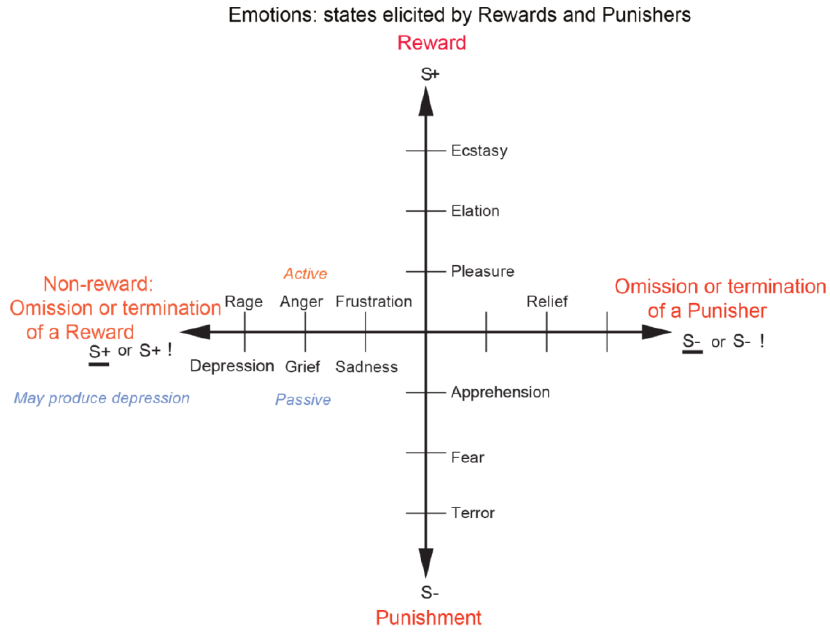
Figure 4 : Some of the emotional states associated with different reinforcement contingencies are indicated. Intensity increases away from the centre of the diagram, on a continuous scale. The classification scheme shows how different emotional states created by the different reinforcement contingencies consist of being in a state that leads to (1) performing an action to obtain a reward (S+), (2) performing an action to escape from or avoid a punisher (S-), (3) performing an action, or not, because of the omission of a reward (S+) (extinction) or the termination of a reward (S+!) (time out), and (4) performing an action, or not, because of the omission of a punisher (S-) (avoidance) or the termination of a punisher (S-!) (escape). Note that the vertical axis describes emotional states associated with the delivery of a reward (up) or punisher (down). The horizontal axis describes emotional states associated with the non- delivery of an expected reward (left) or the non-delivery of an expected punisher (right). For the contingency of non- reward (horizontal axis, left), different emotions can arise depending on whether an active action is possible to respond to the non-reward, or whether no action is possible, which is labelled as the passive condition. The diagram summarizes the emotional states that might arise for one reinforcer as a result of different contingencies. Every separate reinforcer has the potential to operate according to contingencies such as these. Each different reinforcer will produce different emotional states, but the contingencies will operate as shown to produce different specific emotional states for each different reinforcer. The diagram does not imply a dimensional theory of emotion, but shows the type of emotional state that might be produced by a specific